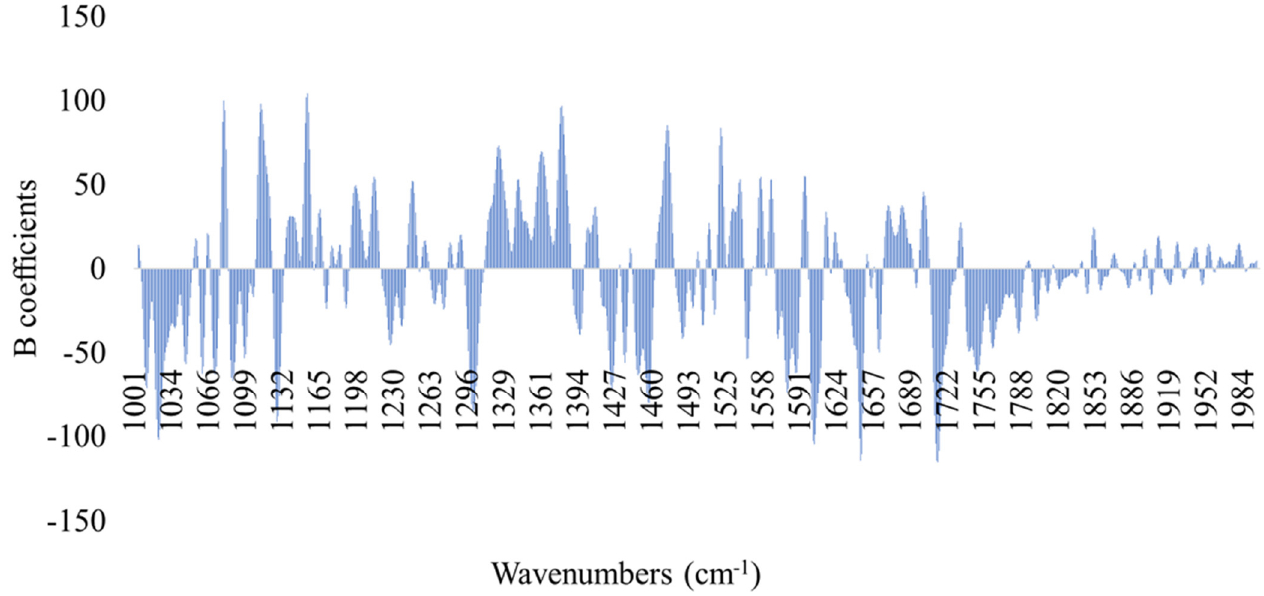
Figure 8. Beta (B) coefficients for PLS-R model developed on FT-IR spectral data for chicken thigh